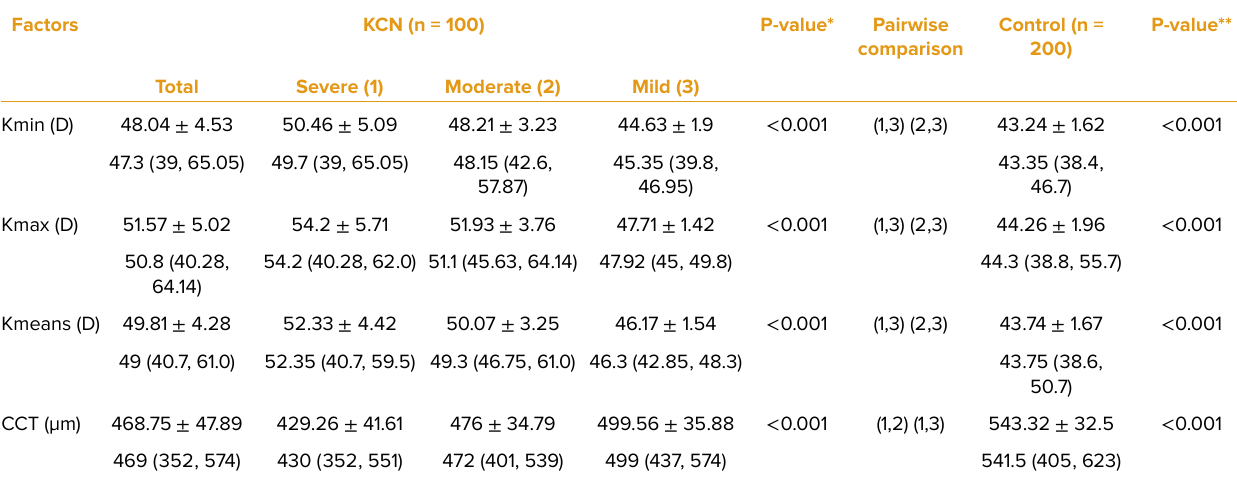
Table 3. Comparison of topo- and tomographic findings in case and control groups. Factors KCN (n =